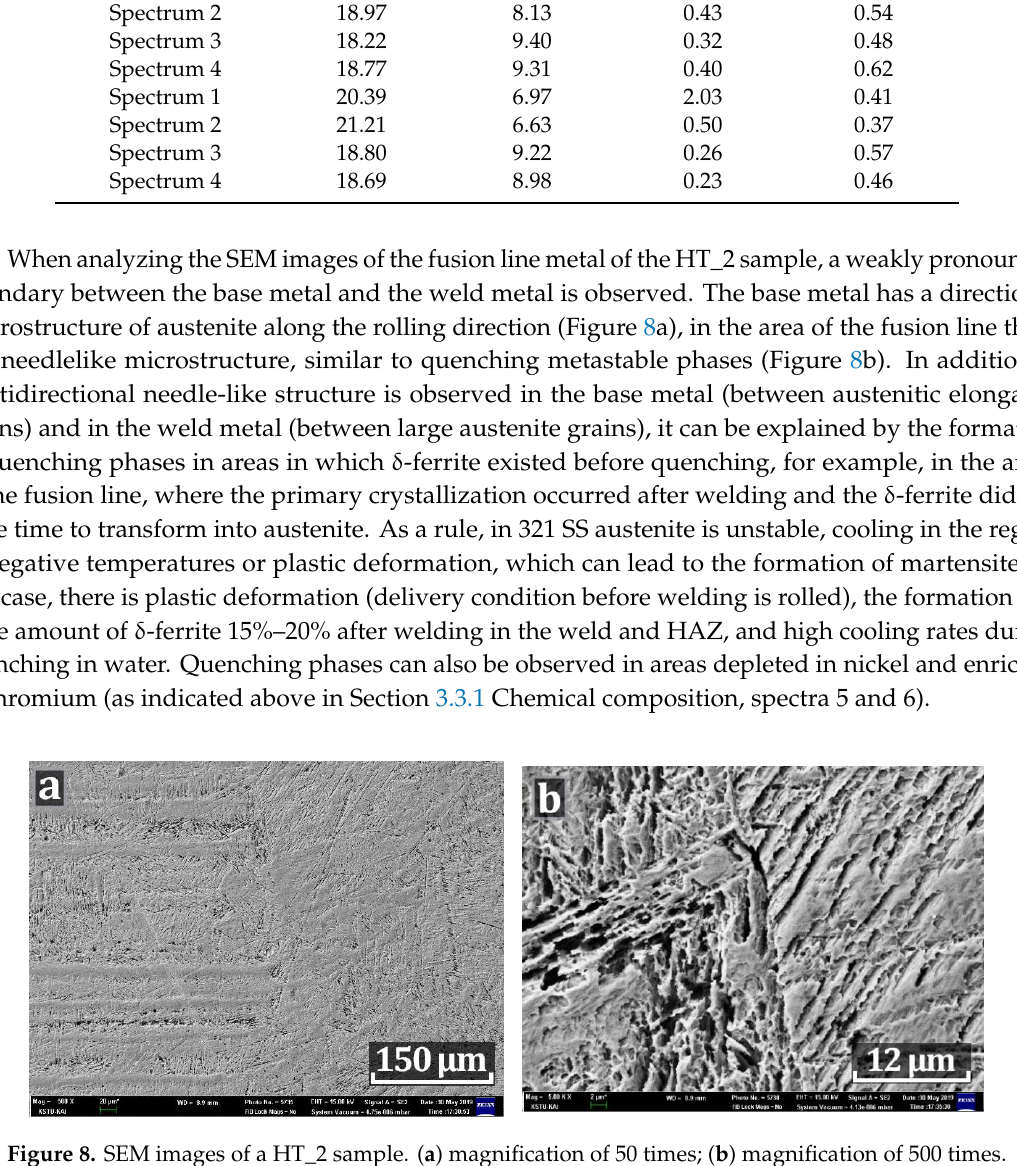
Figure 8. SEM images of a HT_2 sample. ( a ) magnification of 50 times; ( b ) magnification of 500 times.